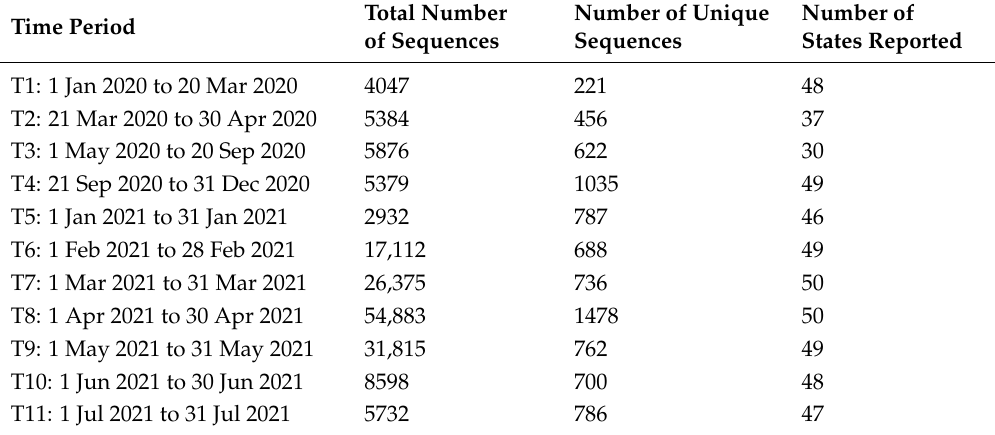
Table 1. Dataset